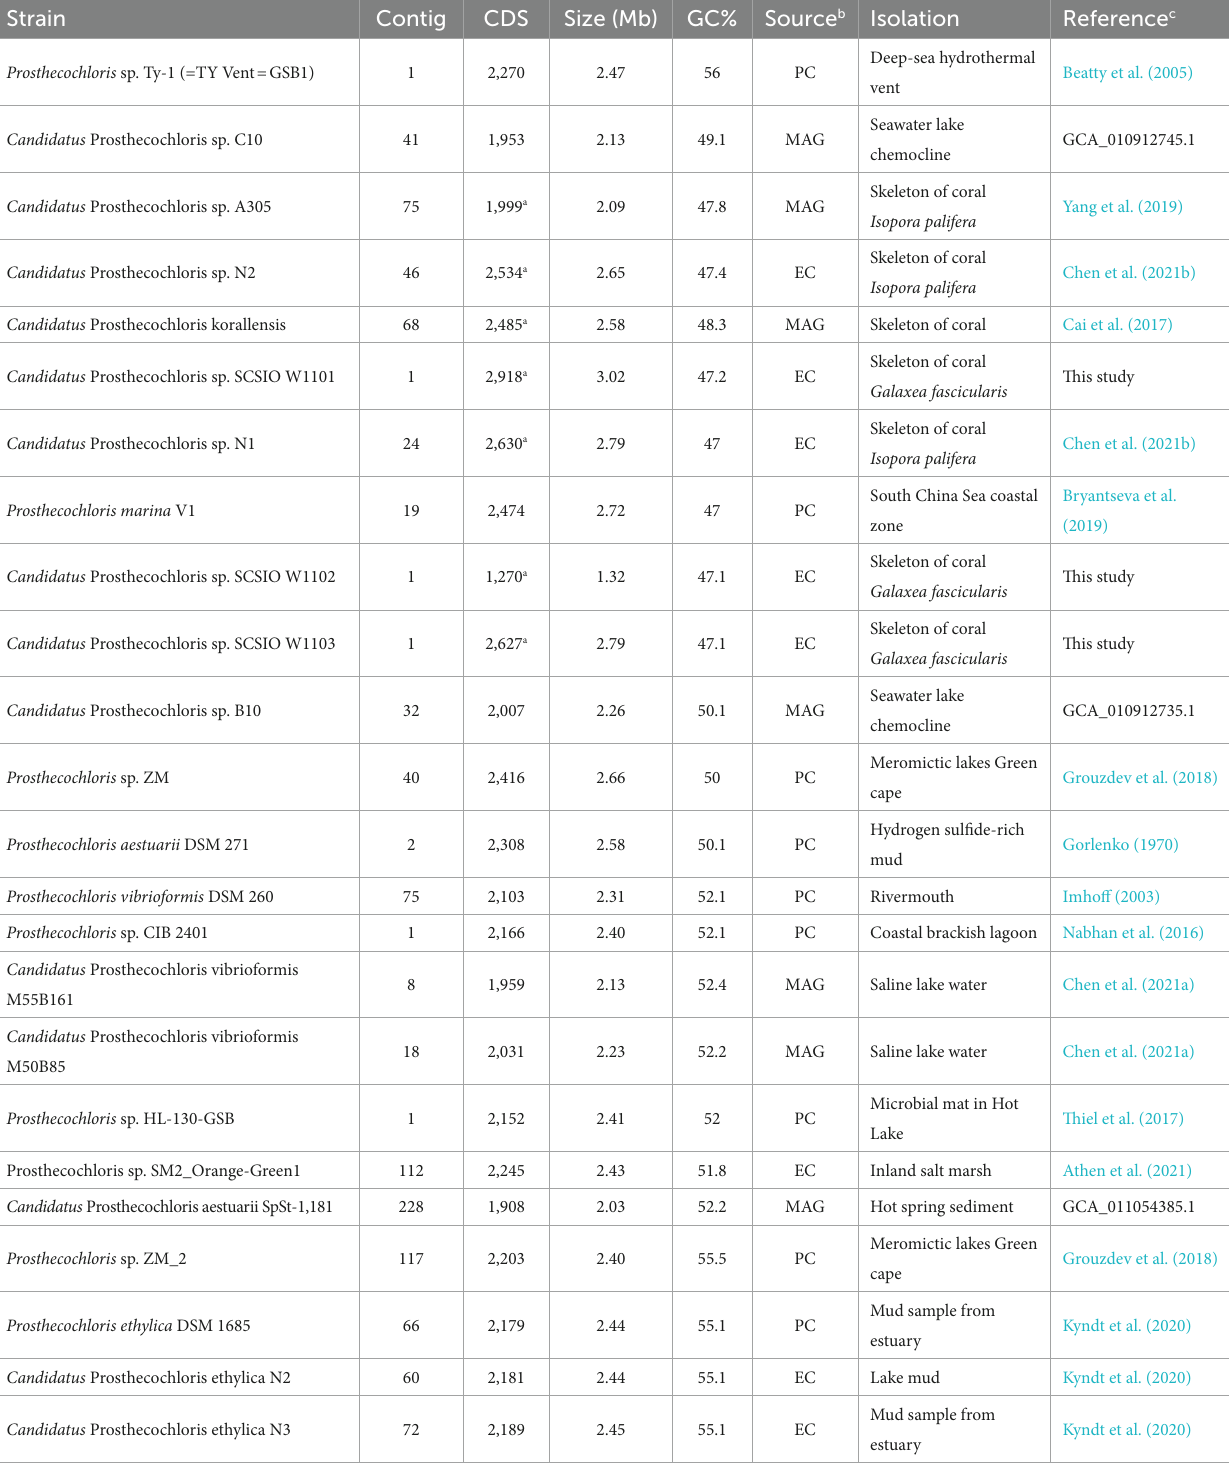
TABLE 1 Information of Prosthecochloris genomes assembled from pure cultures, enrichment cultures or metagenomes.